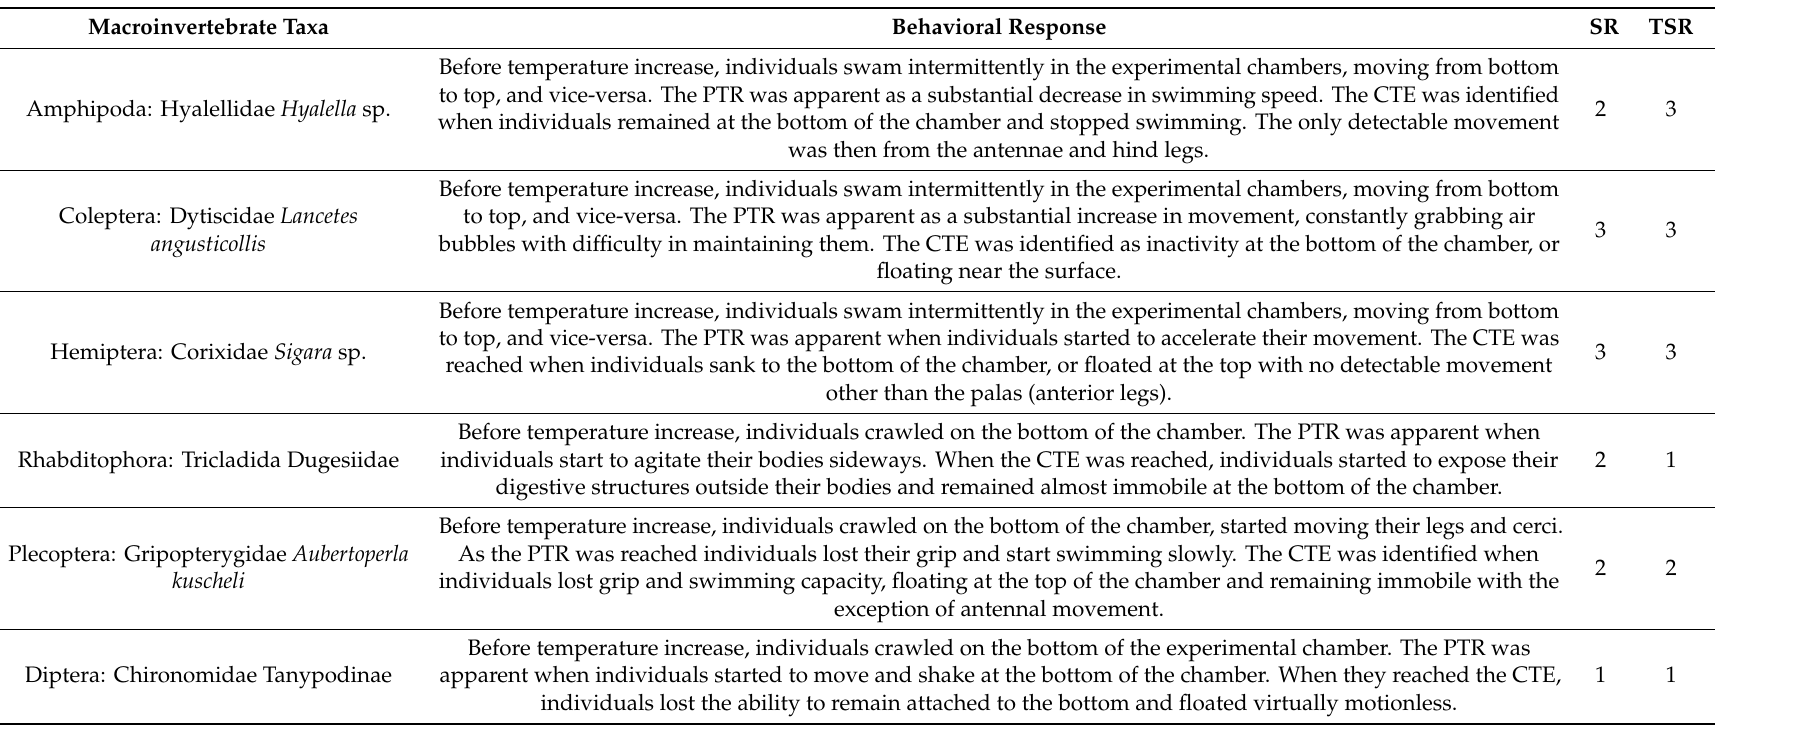
Table 4. Behavioral responses to water temperature increase (point of thermal reactivity, PTR, and critical thermal endpoint, CTE) of sub-Antarctic macroinvertebrate taxa. Suitability ranks SR: 1 = very suitable, 2 = suitable with limitations, and 3 = not suitable, and thermal sensitivity rank TSR: 1 = very sensitive ( ≤ 25 ◦ C), 2 = moderately sensitive ( ≤ 30 ◦ C), and 3 = less sensitive ( ≥ 30 ◦ C) (adapted from Dallas and Rivers-Moore